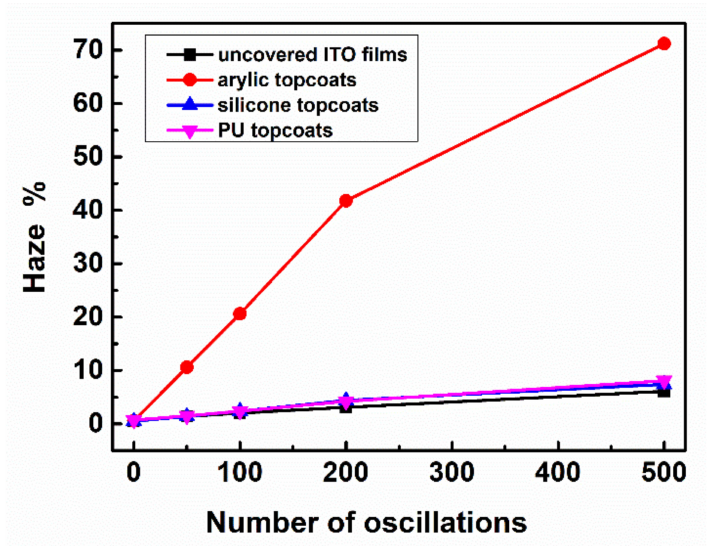
Figure 2. Haze changes of four kinds of transparent specimen (uncovered ITO films, ITO films covered by acrylic-based, silicone and PU topcoats) after different oscillation times.